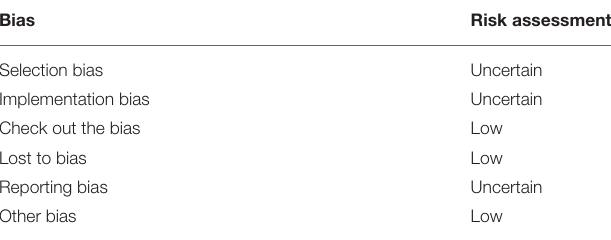
TABLE 2 | Risk of bias